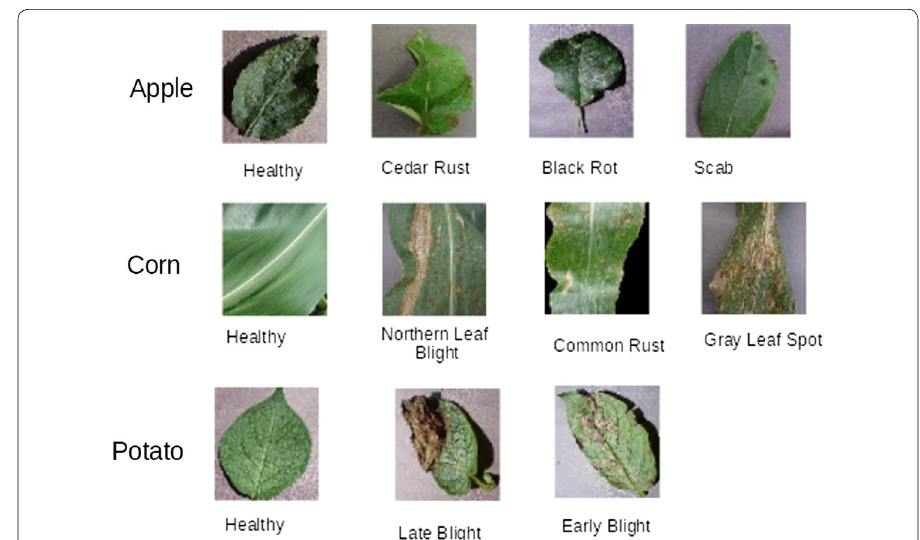
Fig. 10 Samples of training images for Plantvillage dataset